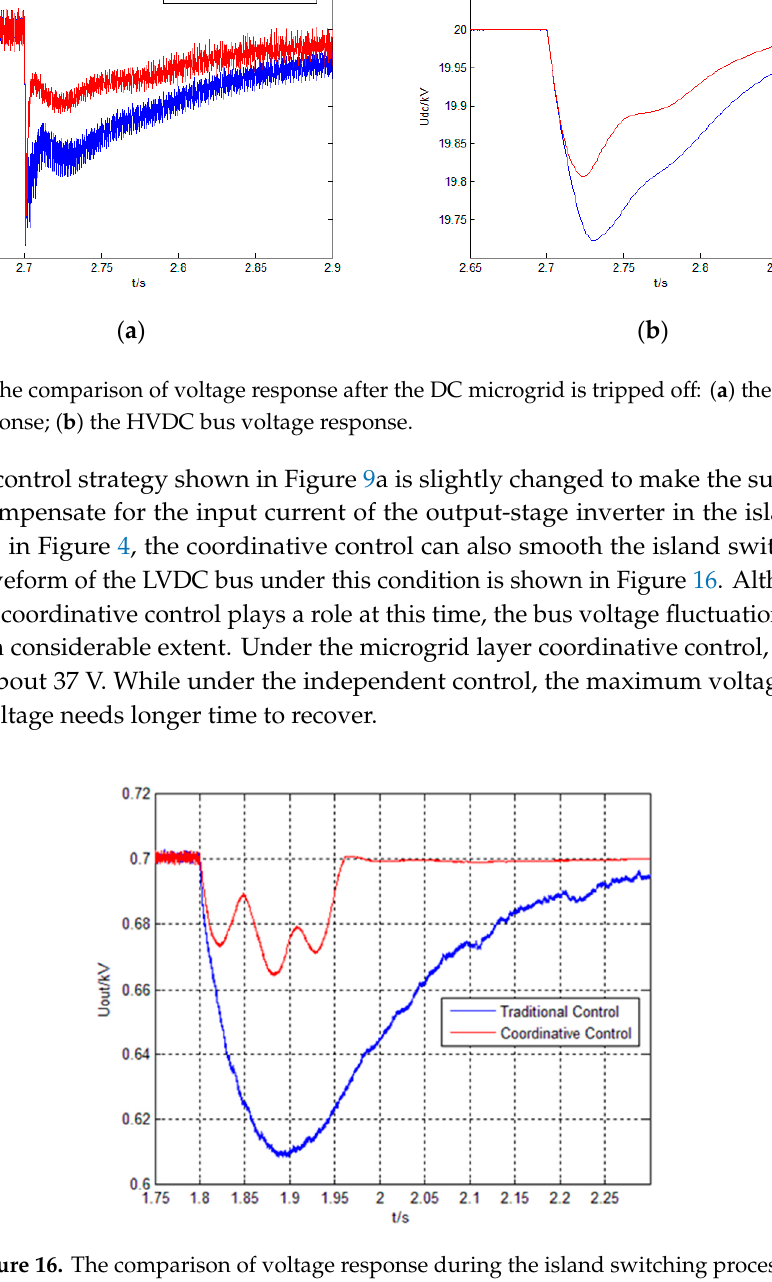
Figure 14. The current waveform of the SST under continuous power fluctuation: ( a ) the distribution network current; ( b ) the HVDC-link current; ( c ) the LVDC-link current.